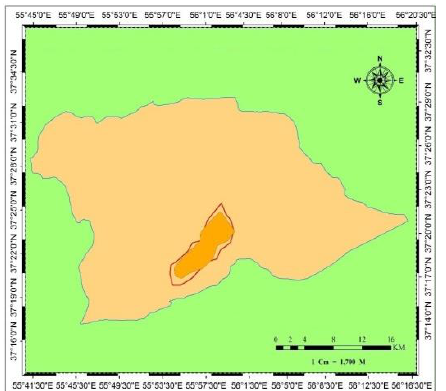
Figure 11. Simulated and real fire propagation maps